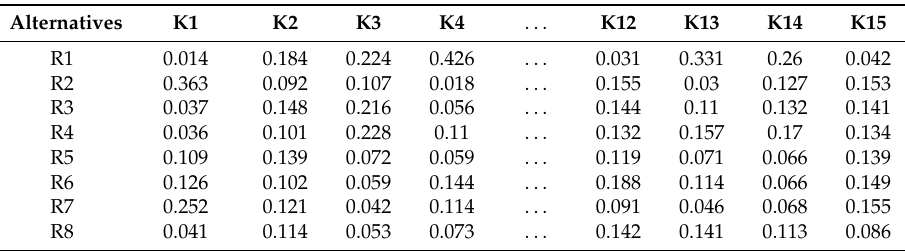
Table 5. Normalized weighted